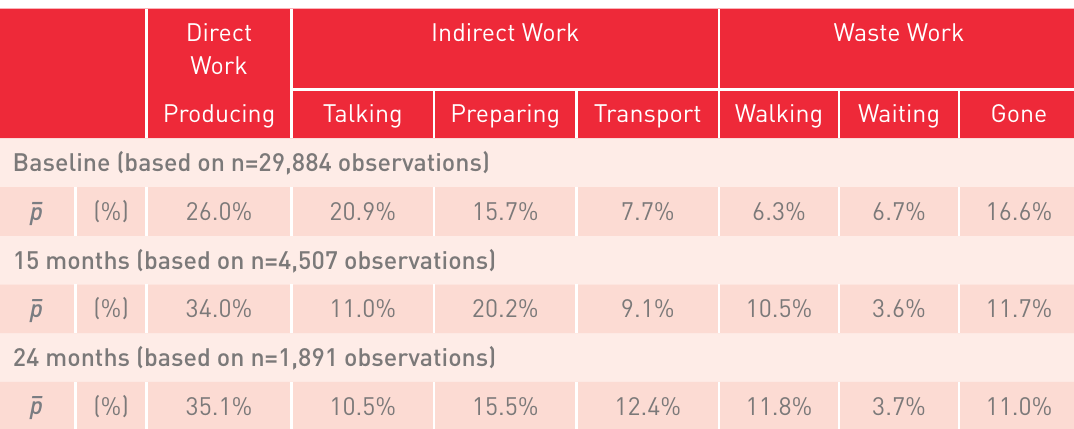
Table 8. WS data collected on case 1 Direct Indirect Work Waste Work Work Producing Talking Preparing Transport Walking Waiting